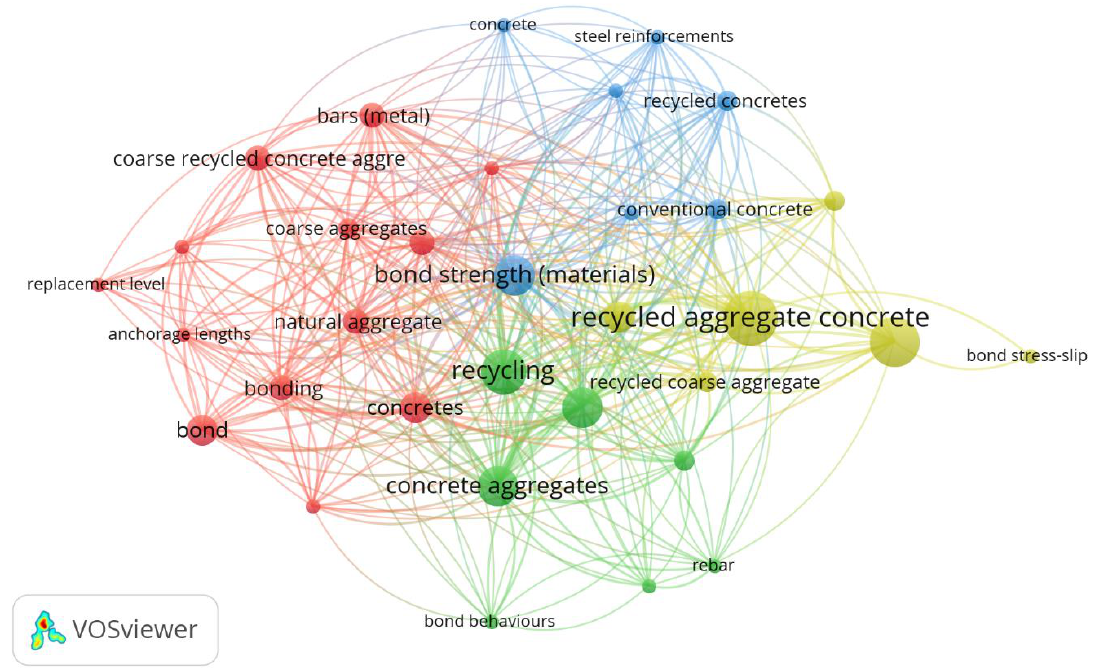
Figure 5. Clustering of keywords from the selected bibliography.